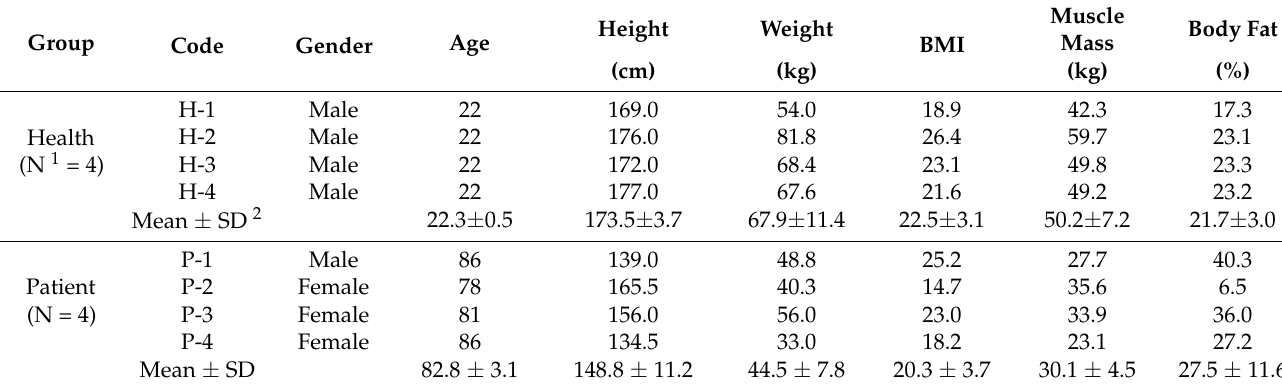
Table 1. Summary of the participants’ physical information.